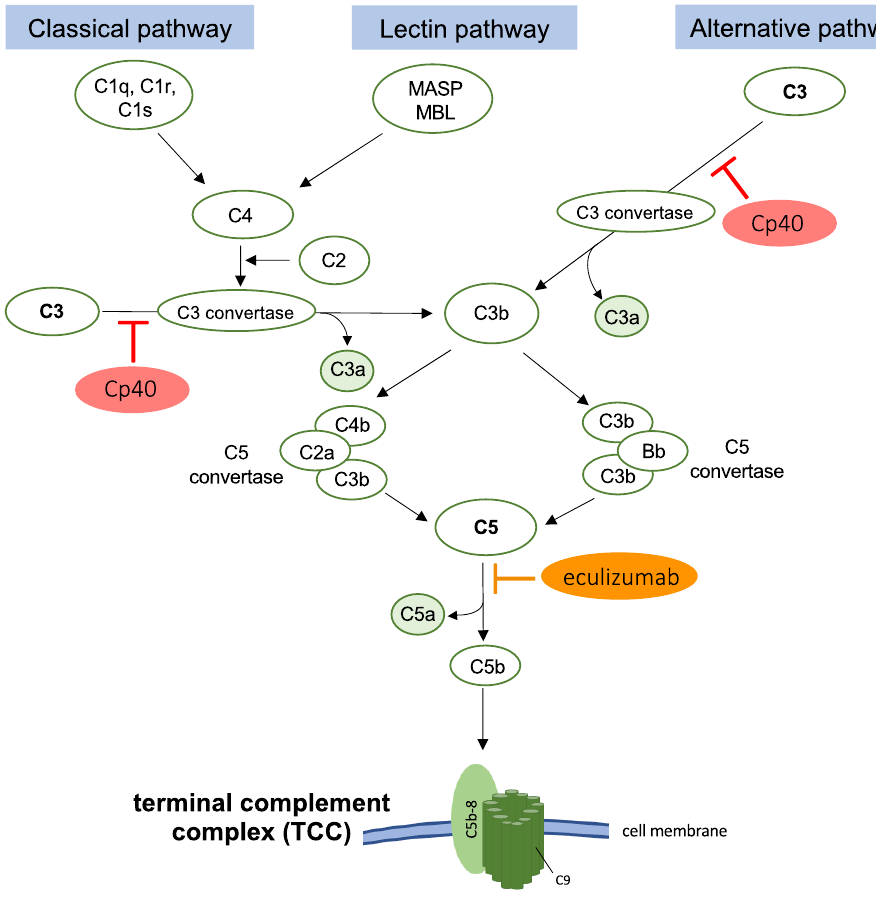
Figure 1. Schematic illustration of the complement cascade. Complement activation conventionally occurs via three main pathways (classical pathway, lectin pathway, or alternative pathway) and starts a cascade that leads to activation of the central factor C3. C3 convertase mediates the cleavage of C3 into anaphylatoxin C3a and C3b. Subsequent cleavage of C5 into anaphylatoxin C5a and C5b is mediated by C5 convertase (C4bC2aC3b or C3bBbC3b). C5b represents the initial component of terminal complement complex (TCC) assembly, which is formed by C5b, C6, C7, C8, and C9 molecules at a cell membrane. C3 inhibitor Cp40 prevents the cleavage of the central complement component C3. Eculizumab inhibits the cleavage of C5. Both inhibitors thereby prevent activation of the terminal pathway (TCC assembly).